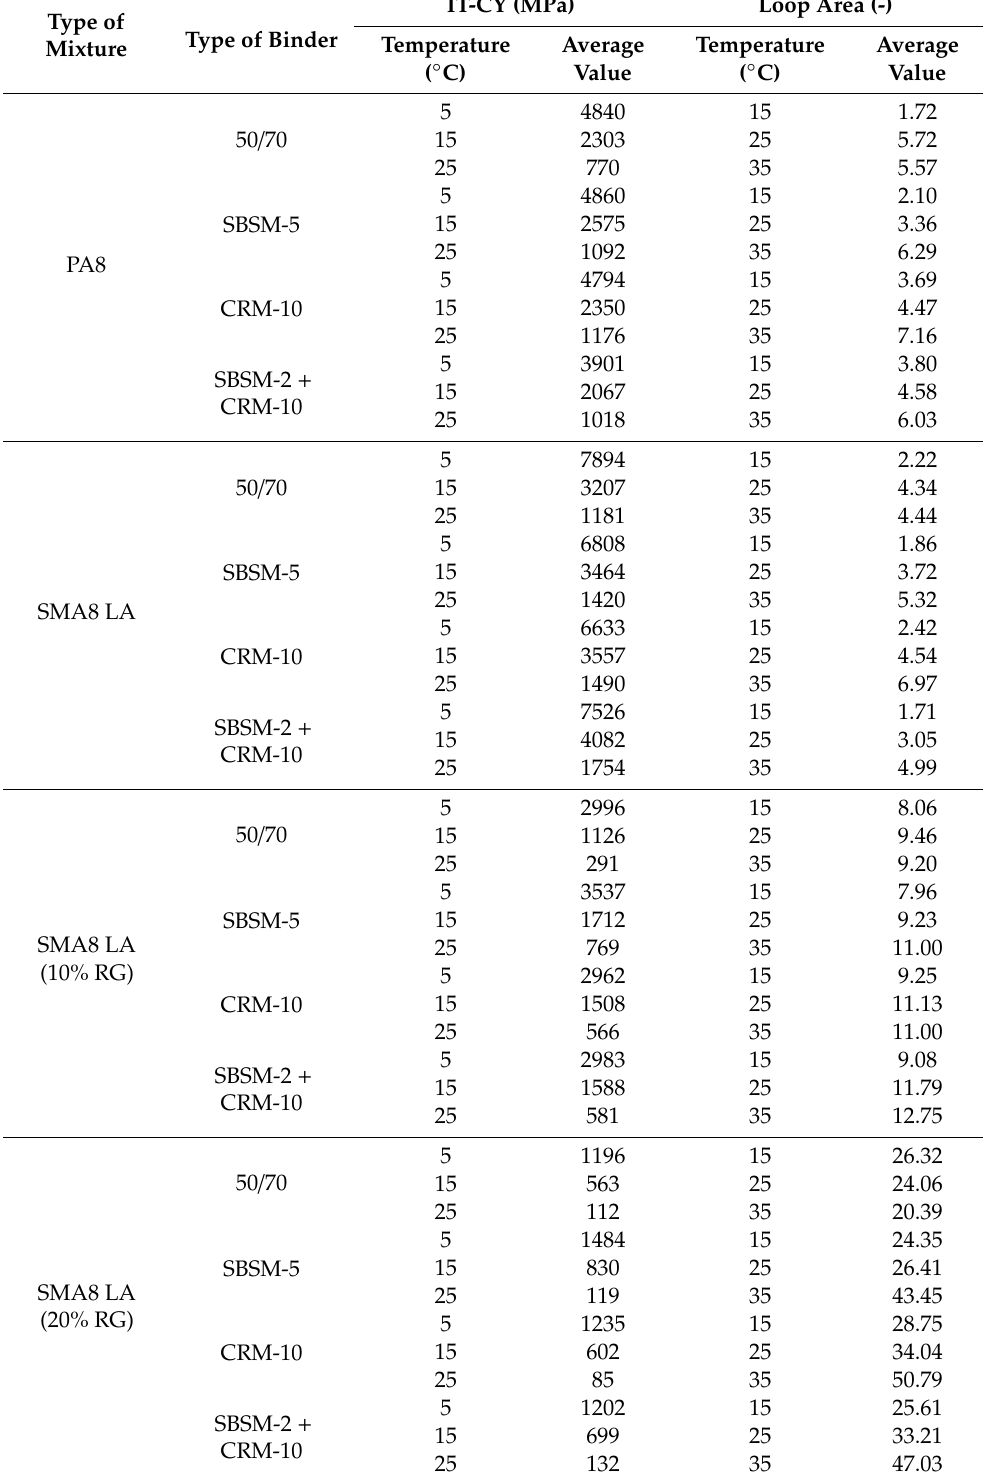
Table 5. Test results of sti ff ness modulus and area of elastic hysteresis loop for particular types of mixtures depending on the modifier